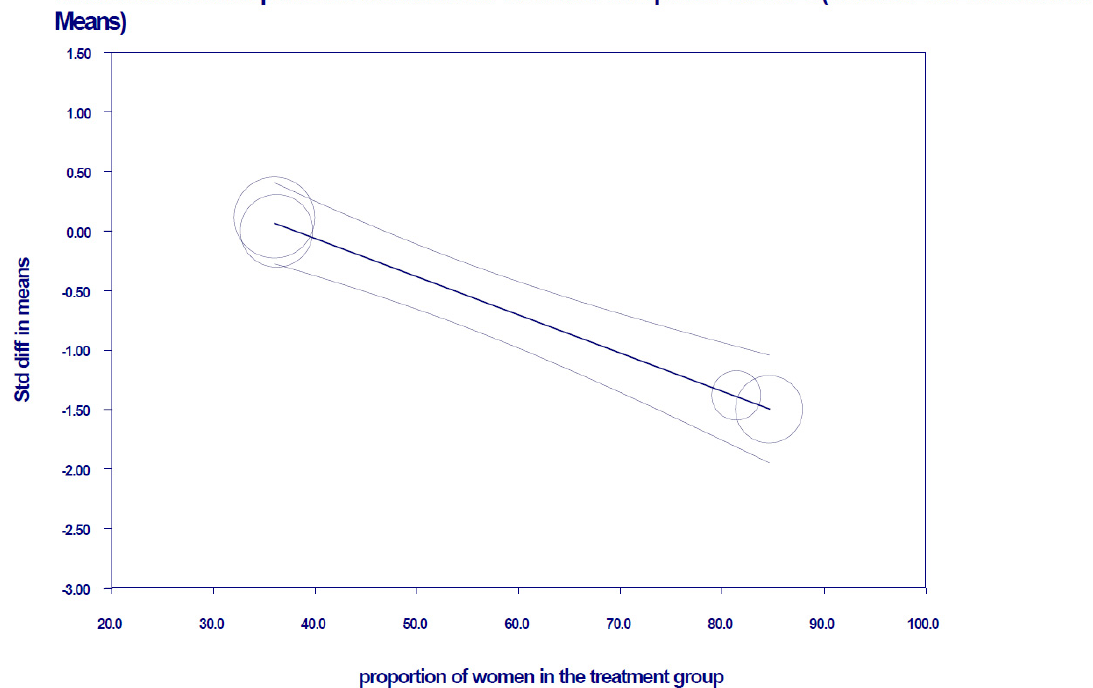
Figure 4. Linear relationship with 95% confidence intervals between the moderating variable “percentage of women” in the meta-analysis studies and the standardized mean observed effect size of BMI (mixed-effects). A decrease in BMI is observed in studies that have included a higher percentage of women.